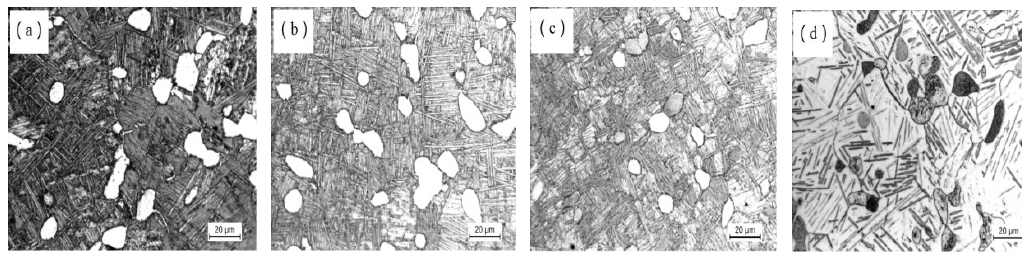
Figure 3. Optical microscopy micrographs of specimens with initially microstructure II after heated up to ( a ) 750 °C; ( b ) 800 °C; ( c ) 860 °C; ( d ) 940 °C at 10 °C/min.